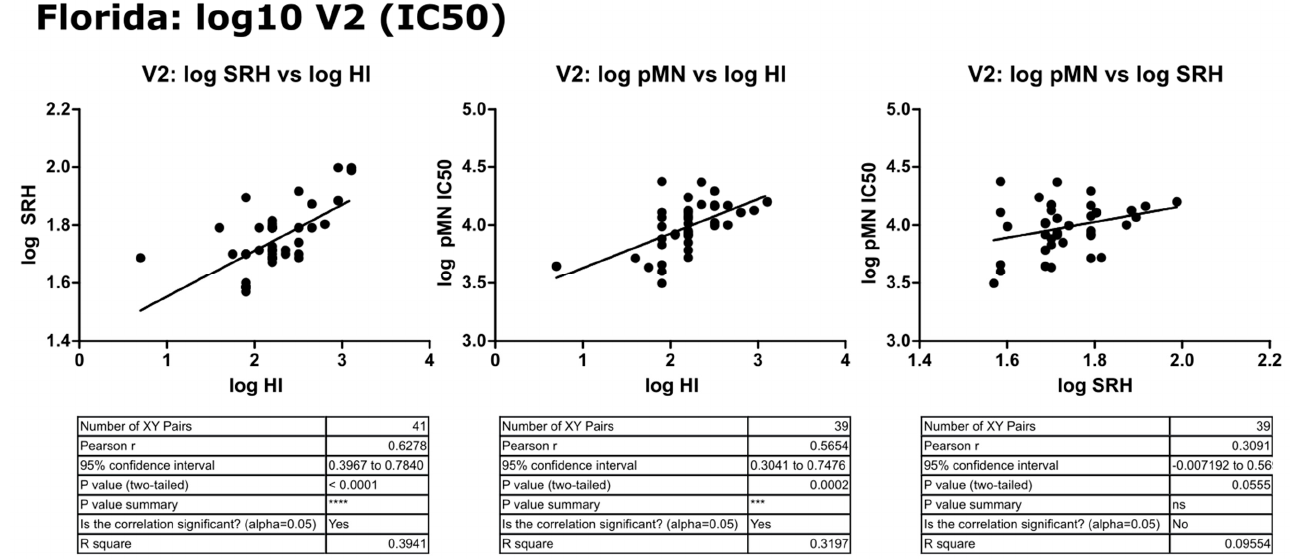
Figure 13. Correlation of transformed (log10) SRH, HI and pMN (IC 50 ) mean V2 values assayed against B/Florida/4/2006 PV. Pearson’s two-tailed analysis performed using GraphPad Prism. Strong correlation is observed between log SRH and HI (Pearsons r = 0.62. log pMN and log HI correlate well (Pearsons r = 0.56), and weak correlation was seen between log pMN and log SRH (Pearsons r = 0.30). p > 0.05 = ns, p ≤ 0.001 = ***, p ≤ 0.0001 = ****.